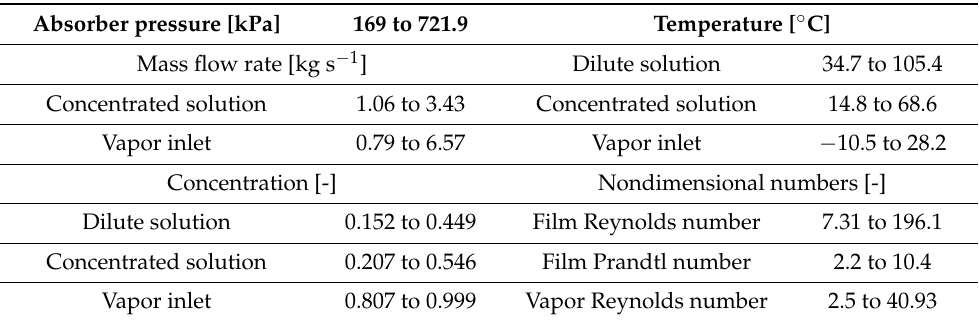
Table 10. Range of applicability of overall Nusselt number correlation, Equation (4) (adapted from Nagavarapu and Garimella